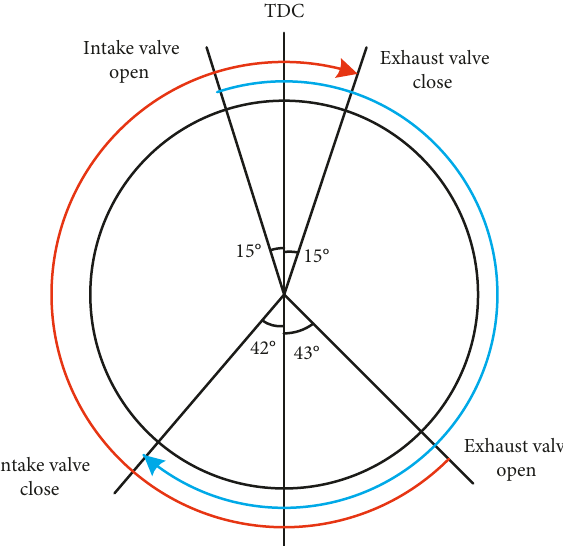
Figure 7: Gas distribution phase